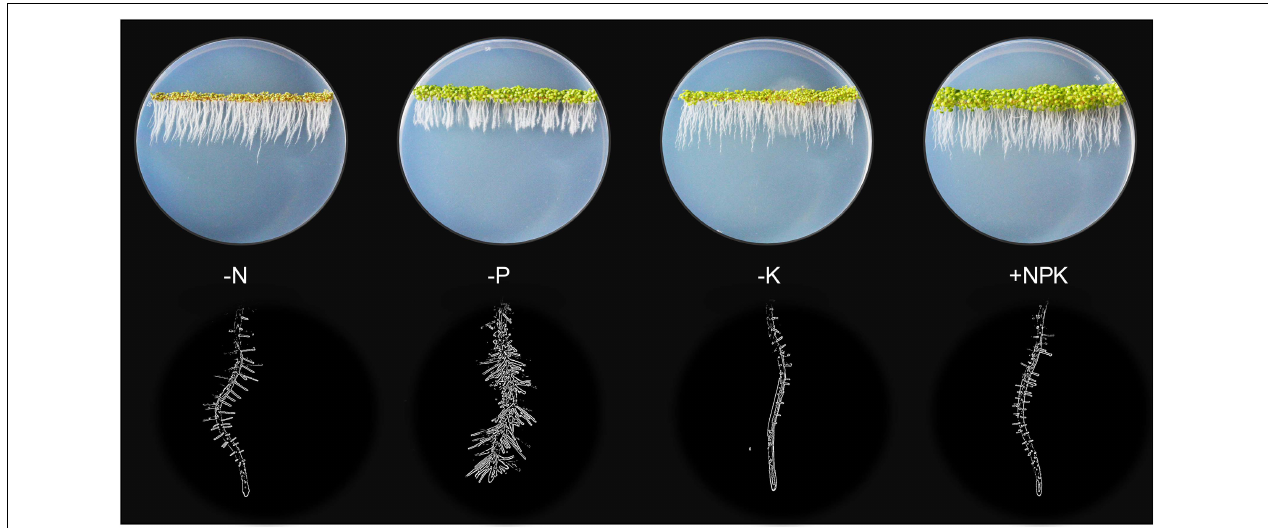
FIGURE 1 | Plant growth highly depends on the continual nutrient supplies. Without N, P, or K (0 mM, 1/6 MS), 5-days old Arabidopsis seedlings displayed stunted shoot growth (top rows) and modified root architectures including primary root and root hair growth (bottom rows) compared to the sufficient-nutrient (1/6 MS) conditions. MS for Murashige and Skoog